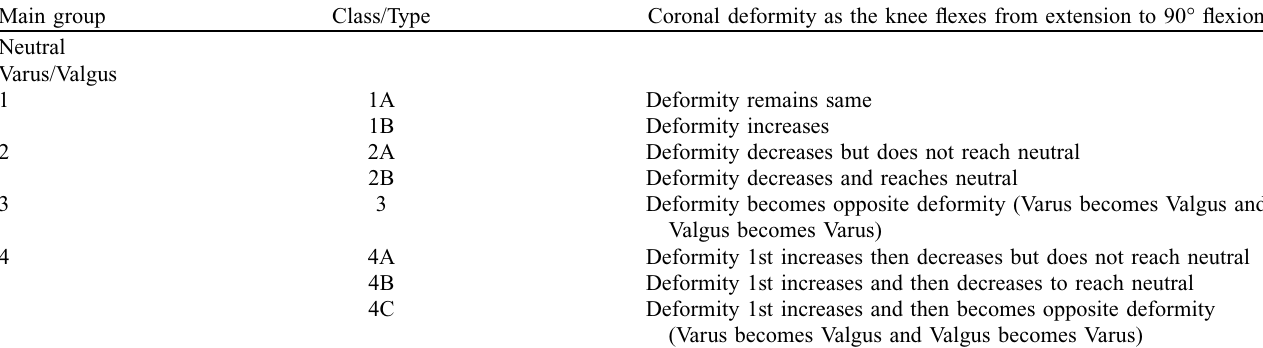
Table 1. Deep’s classification of knee deformity as it flexes from an extended position.